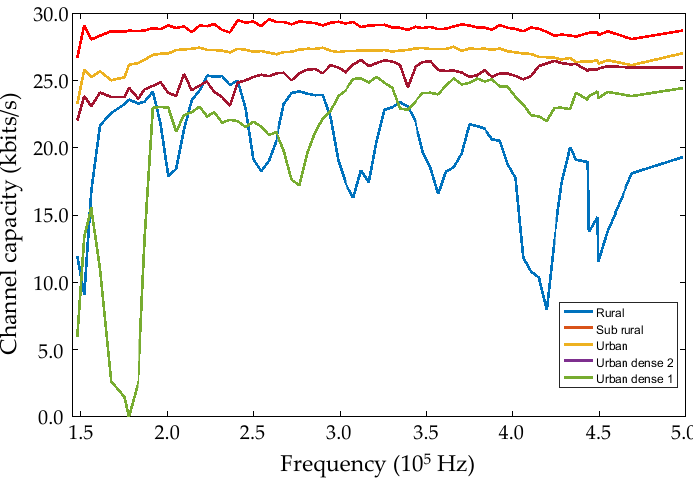
Figure 20. Estimation of the channel capacity in the FCC band.